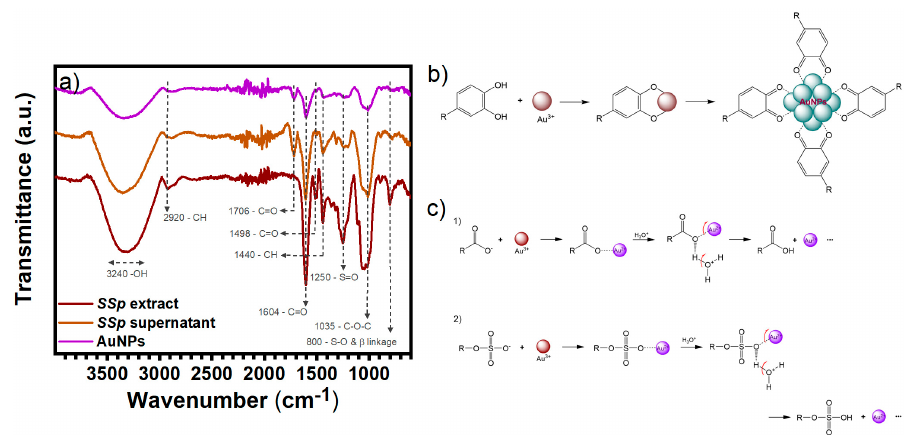
Figure 5. ( a ) FT-IR analysis of AuNPs, and Sargassum sp. extract before and after the synthesis reaction. ( b ) Scheme of the reaction mechanism for AuNPs in the presence of phenolic compounds and ( c ) Scheme for the reaction mechanism for AuNPs in presence of (1) alginic acid and (2) fucoidan.